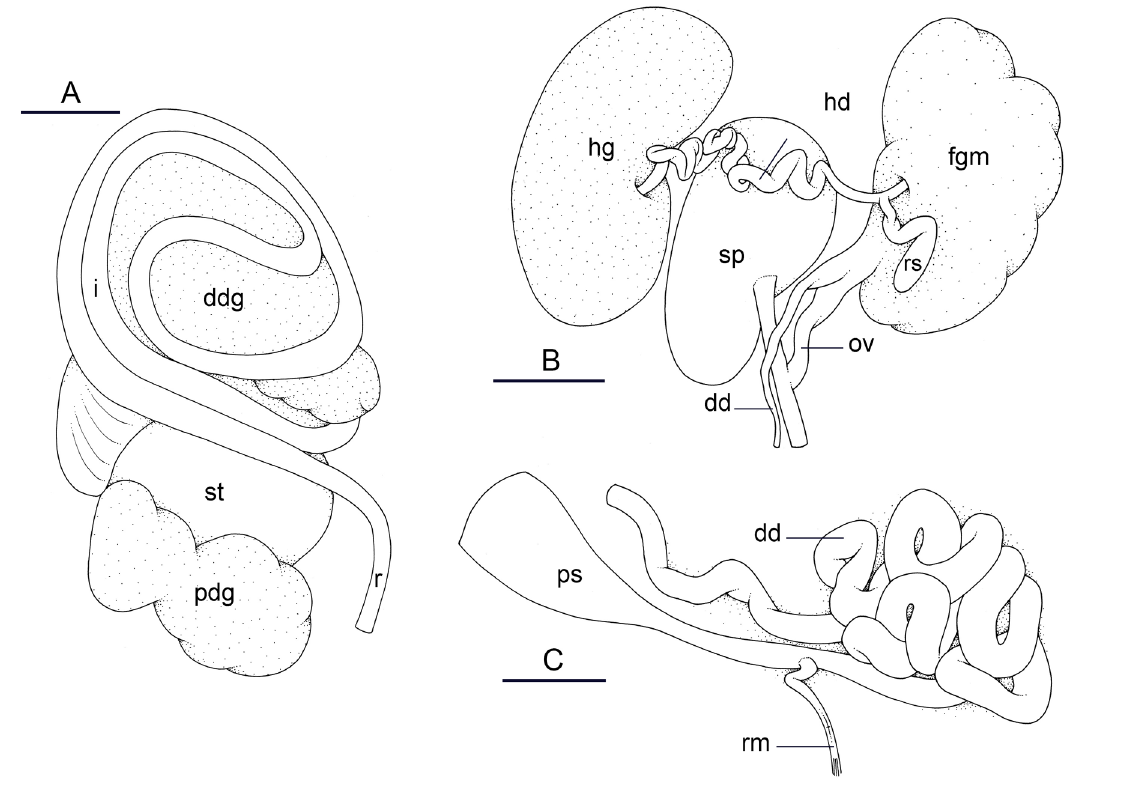
Fig. 47. Paromoionchis goslineri gen. et sp. nov. unit #1, holotype, Philippines, Luzon [3233] (PNM 041271). A . Digestive system. B . Posterior hermaphroditic (female) reproductive system. C . Male copulatory organs. Abbreviations: dd = deferent duct; ddg = dorsal lobe of digestive gland; fgm =